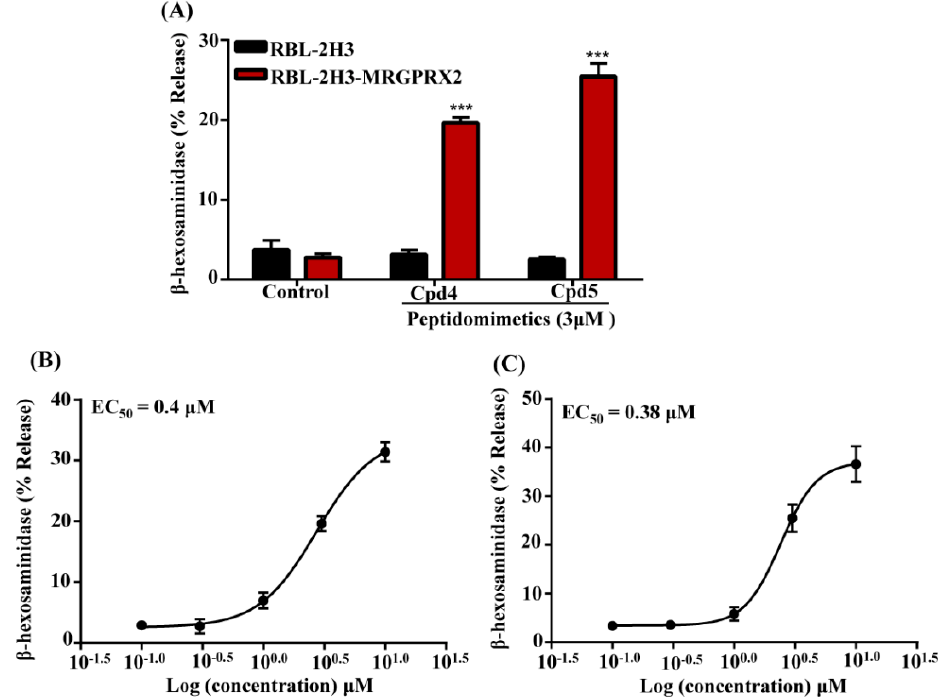
Figure 5. Compound 4 and Compound 5 induce degranulation in RBL-2H3 cells expressing MRGPRX2. ( A ) Untransfected RBL-2H3 cells (RBL-2H3) and cells stably expressing MRGPRX2 (RBL-2H3-MRGPRX2) were exposed to vehicle (Control), smHDPMs compound (Cpd) 4, and Cpd 5 (3 µ M each) for 30 min and percentage of β -hexosaminidase release was determined. Concentration–response curves for ( B ) Cpd 4 and ( C ) Cpd 5 were performed using RBL-2H3-MRGPRX2 cells. Data are presented as mean ± SEM and are representative of three independent experiments in triplicate. Statistical significance was determined by two-tailed unpaired t-Test. *** indicates p value <